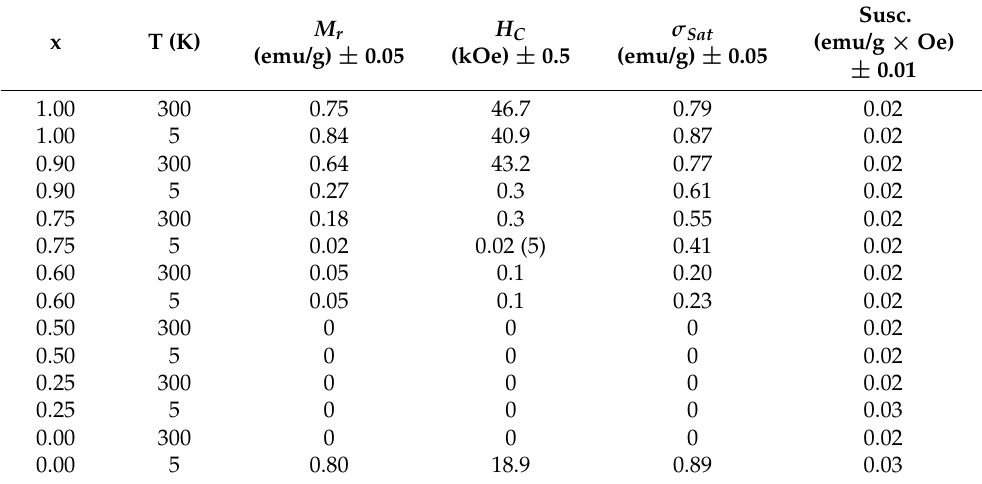
Table 2. Remanence ( M r ), coercive field ( H C ), and magnetic saturation ( σ Sat ) of the ferromagnetic com- ponent, and susceptibility of the antiferromagnetic component to the RSx samples with x = 1, 0.9, 0.75, and 0.60. For the samples with x = 0, 0.25, and 0.50, the values correspond to the ‘paramagnetic’ state.